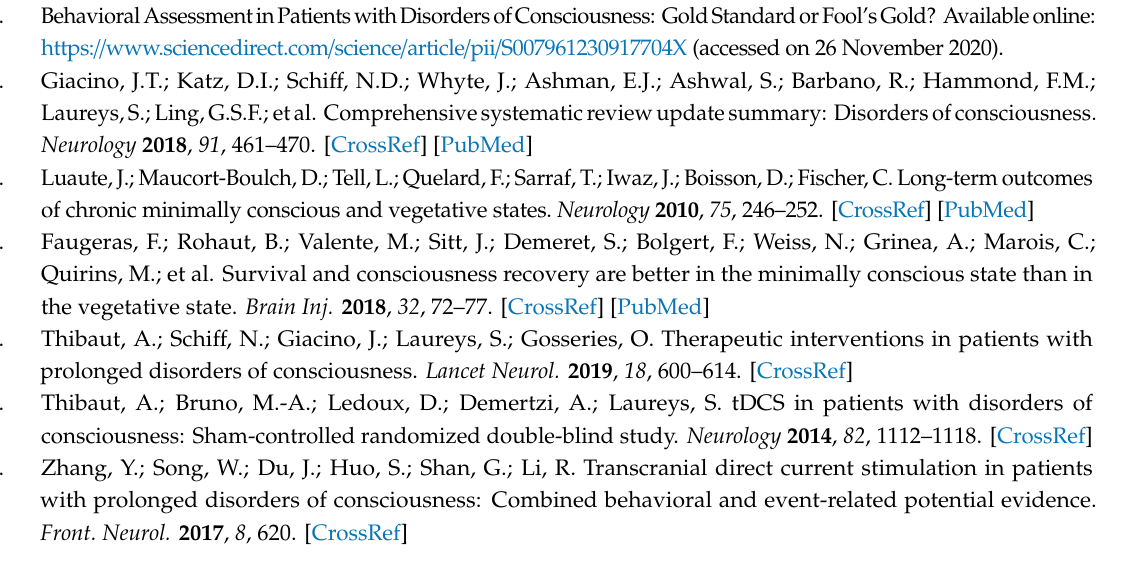
Figure S1: Time-frequency analysis of TMS-evoked